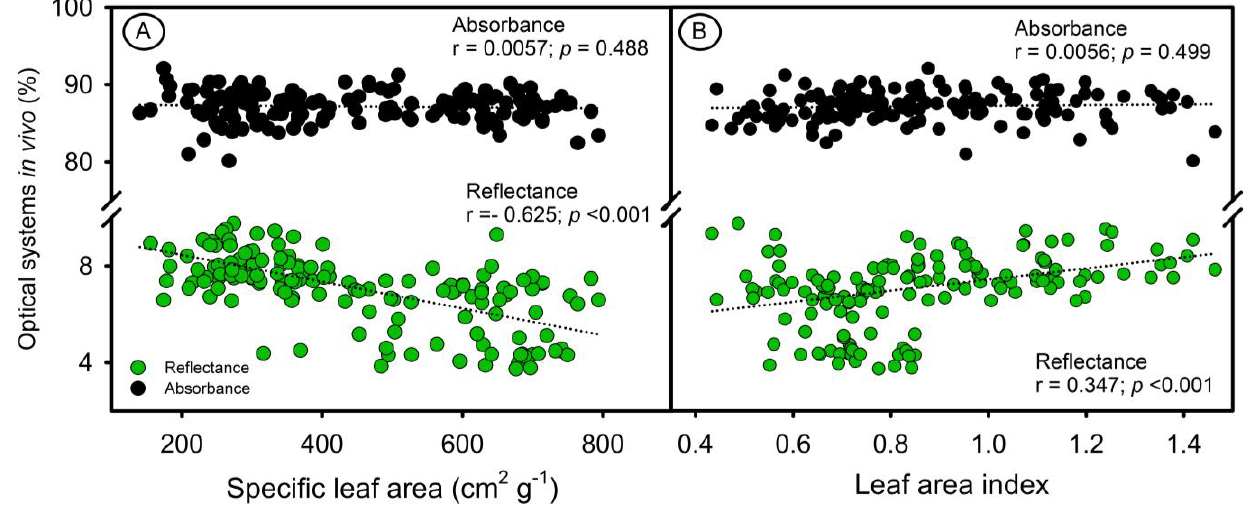
Figure 4. Correlation between reflectance and absorbance in optical systems in vivo . ( A ) Specific leaf area. ( B ) Leaf area index. area. ( B ) Leaf area index.